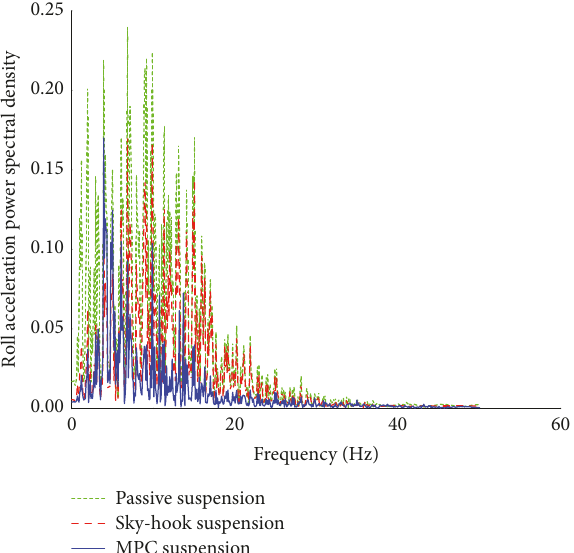
Figure 12: Roll acceleration power spectral